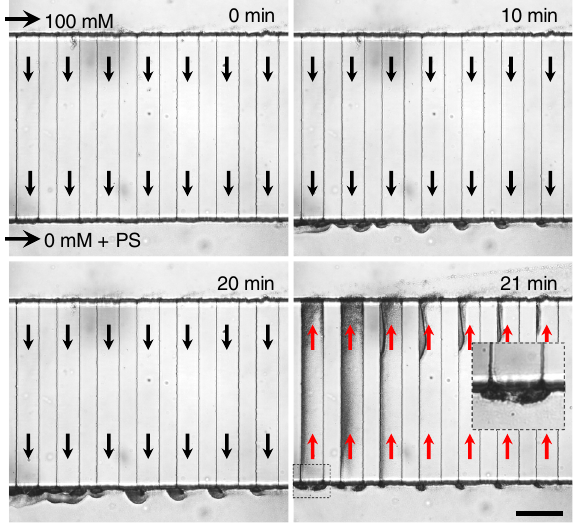
FIG. 4. Small particles can lead to irreversible clogging in large pores. Image sequence of small particles ( 0 . 5 μ m in diameter) accumulating near the large pore mouths ( 50 μ m in width, see Movie 3 in Ref. [6]) due to the outflow of the upper concentrated stream. The solute concentration of the upper stream is c ¼ 100 mM, and the solute concentration of the lower stream 1 is c 2 ¼ 0 mM. Only the lower stream contains polystyrene particles. The bottom-right panel shows clogged particles near the pore mouths after the flow direction within the pores has been reversed. The inset shows a close-up image of the black dashed box. The scale bar is 100 μ